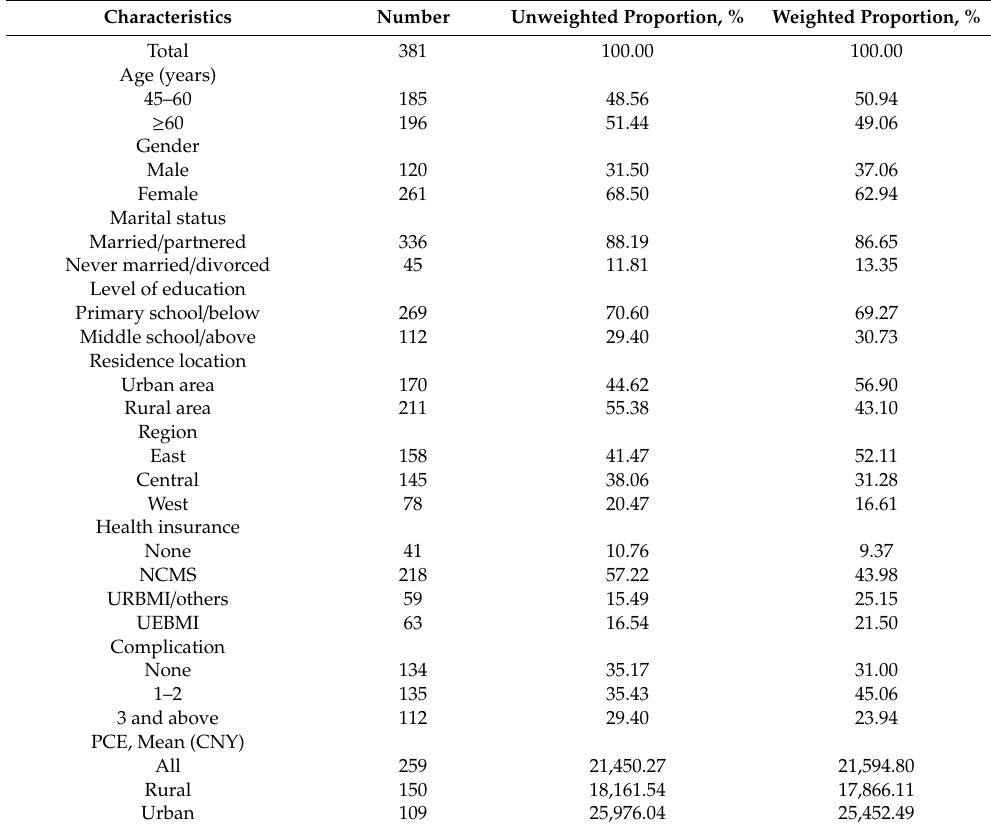
Table 1. Demographic characteristics of the study